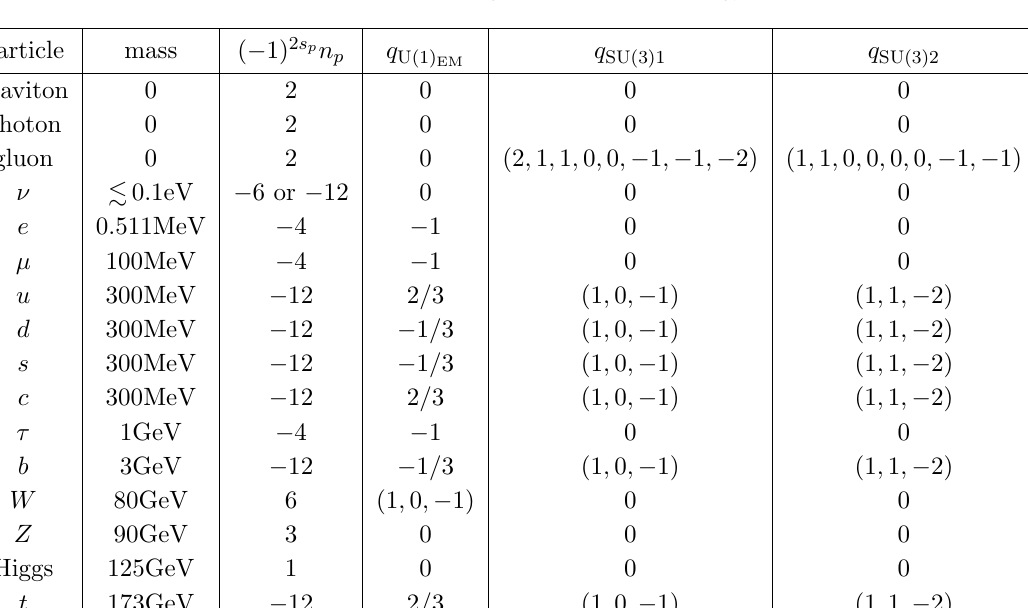
Table 2 . The particle contents contributing to the Casimir energy below the GeV scale.